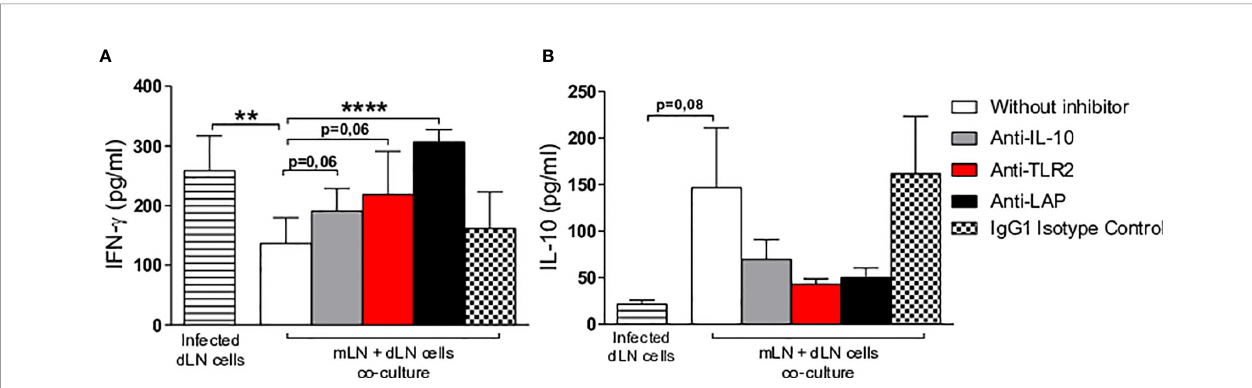
FIGURE 6 | Evaluation of in vitro immune response. Macrophage-derived bone marrow cells from BALB/c mice were infected with L. braziliensis promastigotes at a ratio of 1:10 (cells:parasites) for 24 hours. Co-culturing was performed with infected macrophages, cells from the draining lymph nodes of animals at 10 weeks after infection and cells from the mesenteric lymph nodes of uninfected animals receiving Hsp65-producing L. lactis (collected after 10 days of treatment). Cells were incubated or not in the presence of anti-IL-10, anti-LAP or anti-TLR2. White and colored bars represent co-cultures of infected macrophages with draining and mesenteric lymph nodes cells, while striped bars represent infected draining lymph node cell cultures and hatched bars represent the IgG1 isotype negative control. Cytokine quanti fi cation of (A) IFN- g and (B) IL-10 performed in cell supernatants. For parametric data, Student ’ s t-test was used: (**) P < 0.001; (****) P <